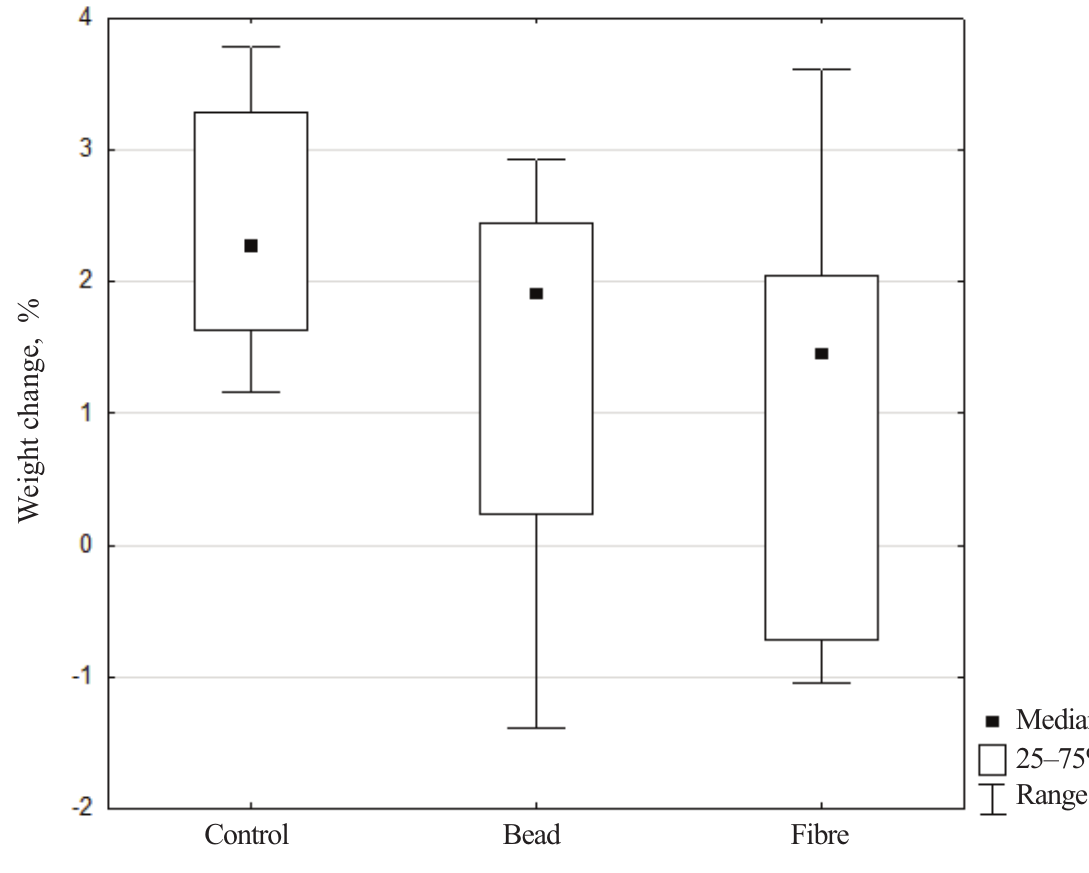
Fig. 3. Weight change of crabs after two­month treatment with contaminated food (except control) followed by unlimited feeding of pure fish for two weeks. One­way ANOVA, N = 6, p >